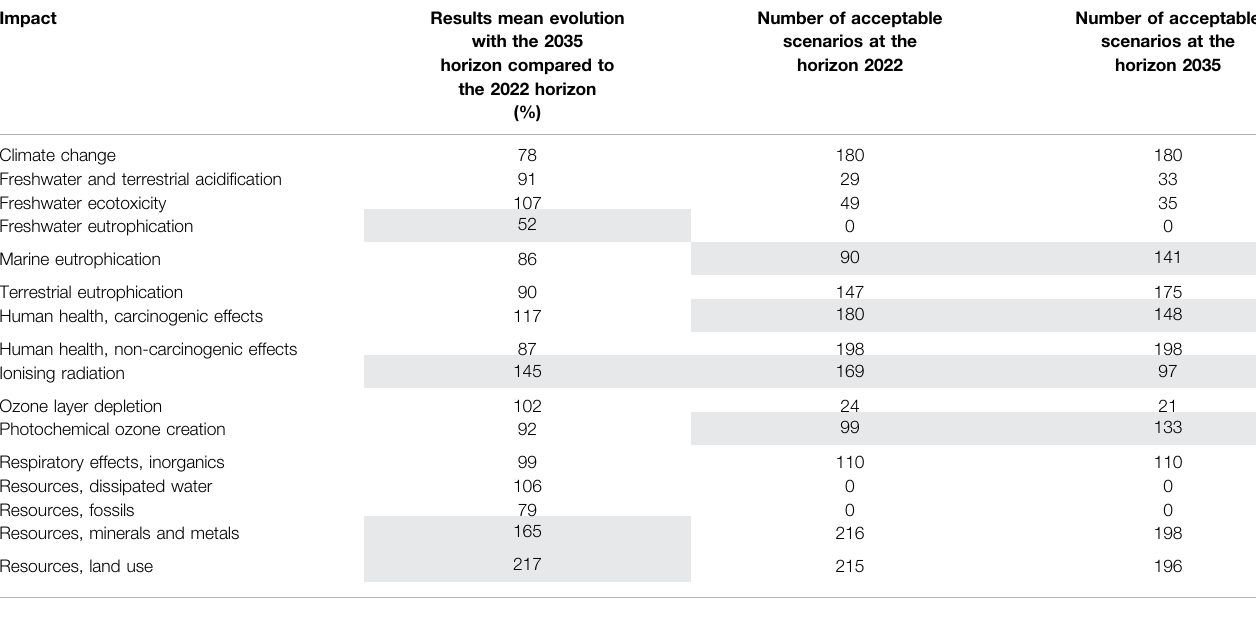
TABLE 4 | Scenarios mean results and acceptable scenarios evolution with the two production time-horizons comparison – grey cells represent largest evolutions.